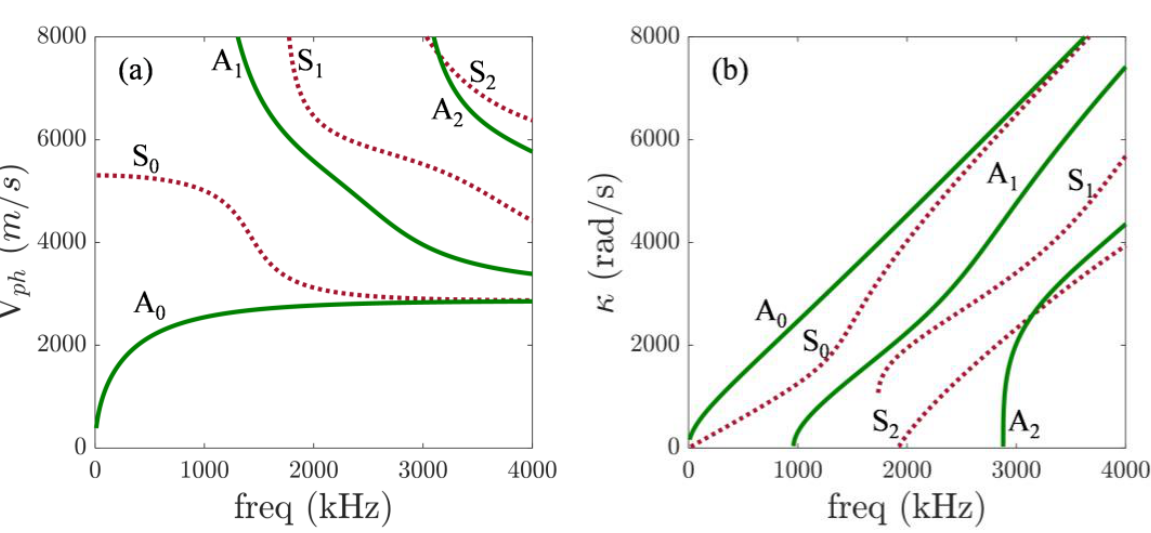
Figure 1. ( a ) Phase velocity and ( b ) wavenumber dispersion curves for a 1.60 mm thick aluminum plate.